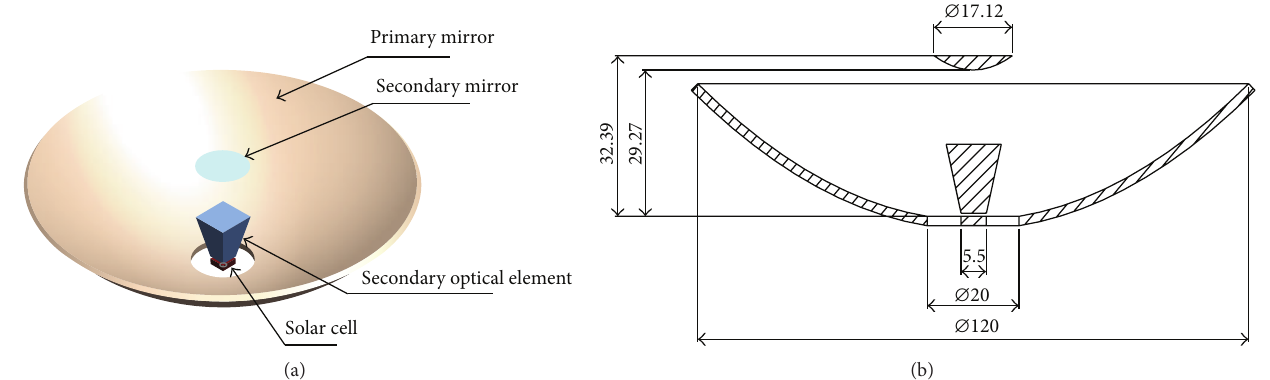
Figure 1: Illustration of the noncoplanar two-reflector solar concentrator.